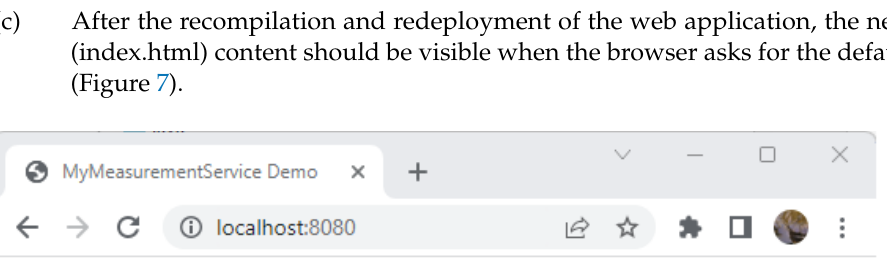
Figure 7. Welcome message page of the web